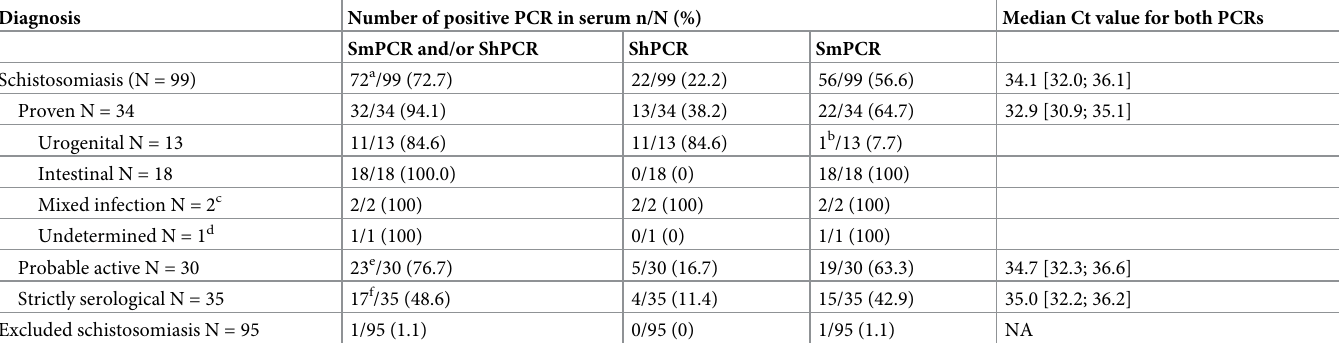
Table 3. Rate of positive serum PCRs in the various clinical categories, according to Schistosoma species (n = 194 patients).